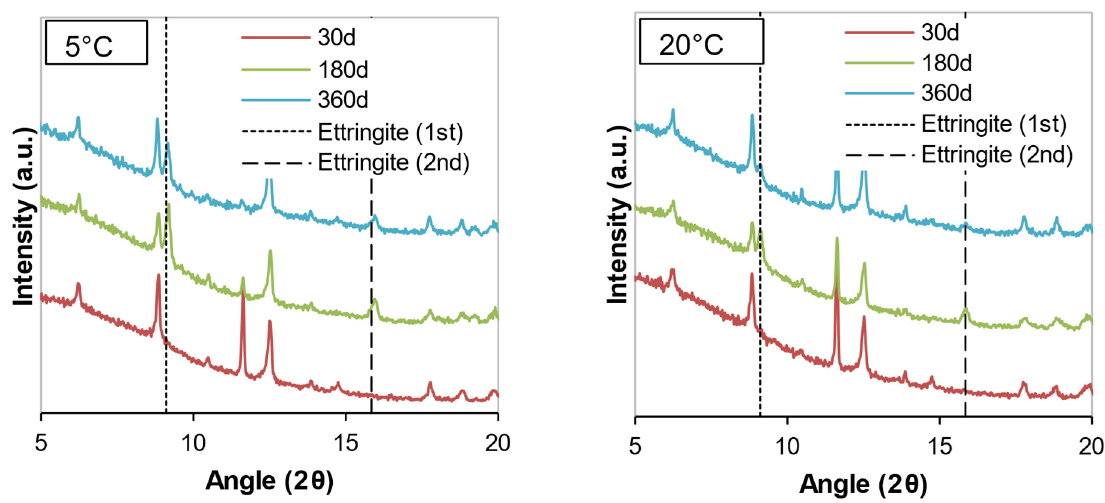
Figure 15. Diffractograms of S + F + W1 at different temperatures.